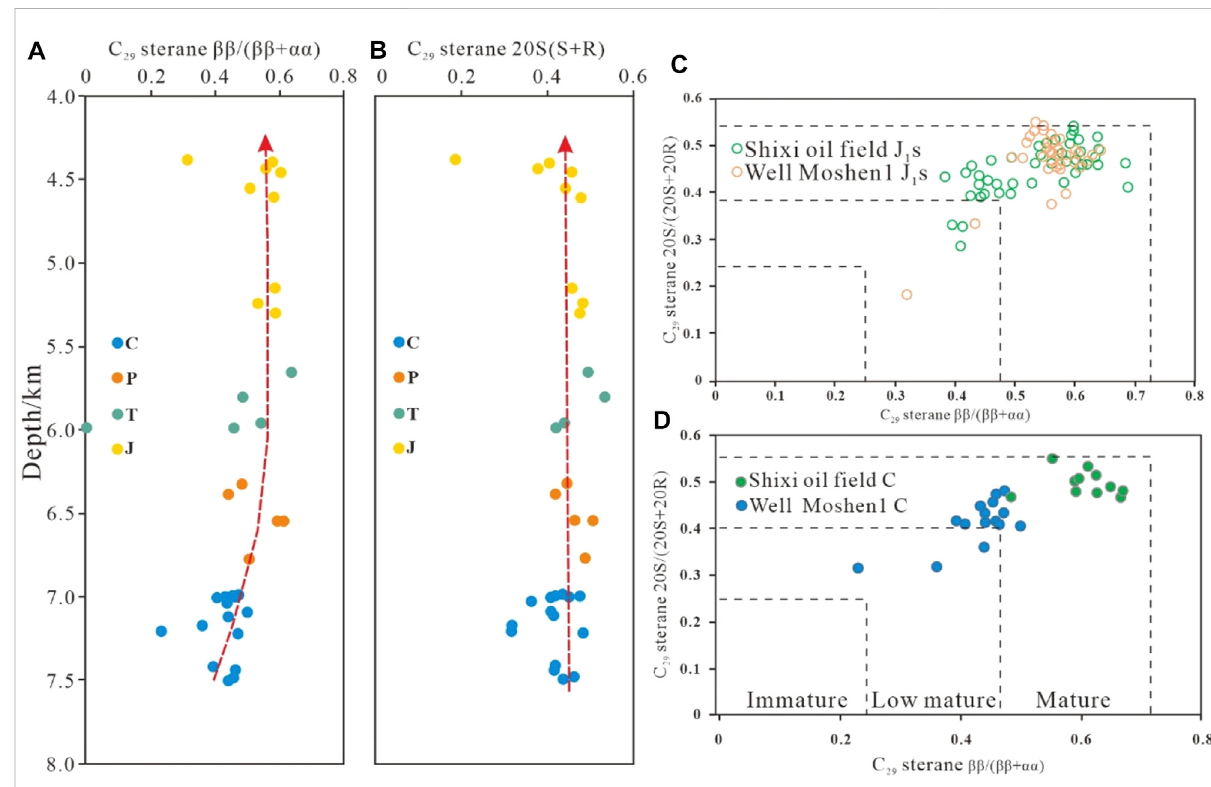
FIGURE 8 Sterane isomerization parameters of crude oils in the Penyijingxi Sag. (A) C 29 sterane ββ /( ββ + αα ) and (B) C 29 sterane ααα 20S/(20S + 20R) versus depth fordeep and shallow crude oilsfrom theMoshen1well intheMosuowanUplift; C 29 sterane ααα 20S/(20S +20R)versusC 29 sterane ββ /( ββ + αα ) for (C) Jurassic and (D) Carboniferous crude oils from the Shixi oil fi eld and Well